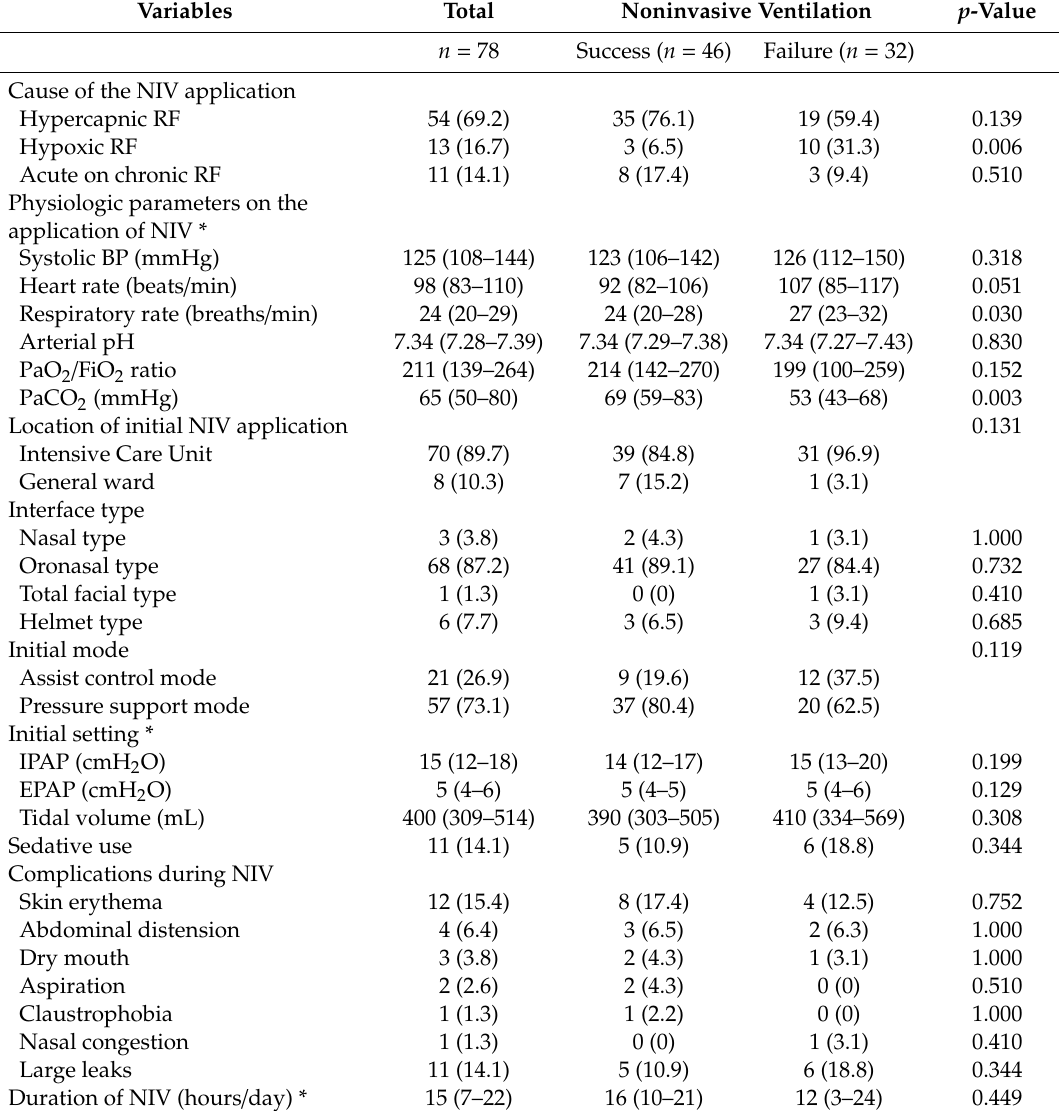
Table 2. Comparison of treatment of patients for whom NIV succeeded and